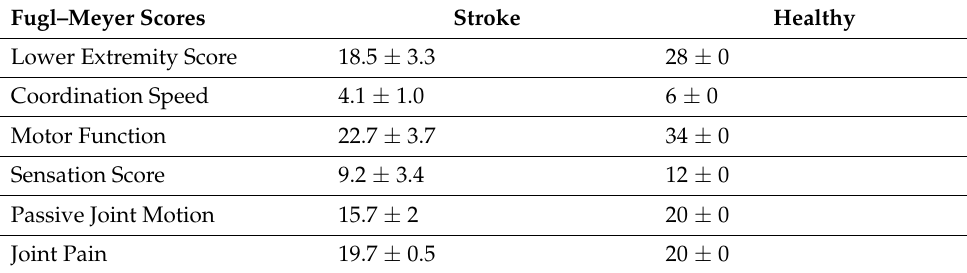
Table 4. Fugl–Meyer scores of fourteen healthy and fourteen stroke participants.